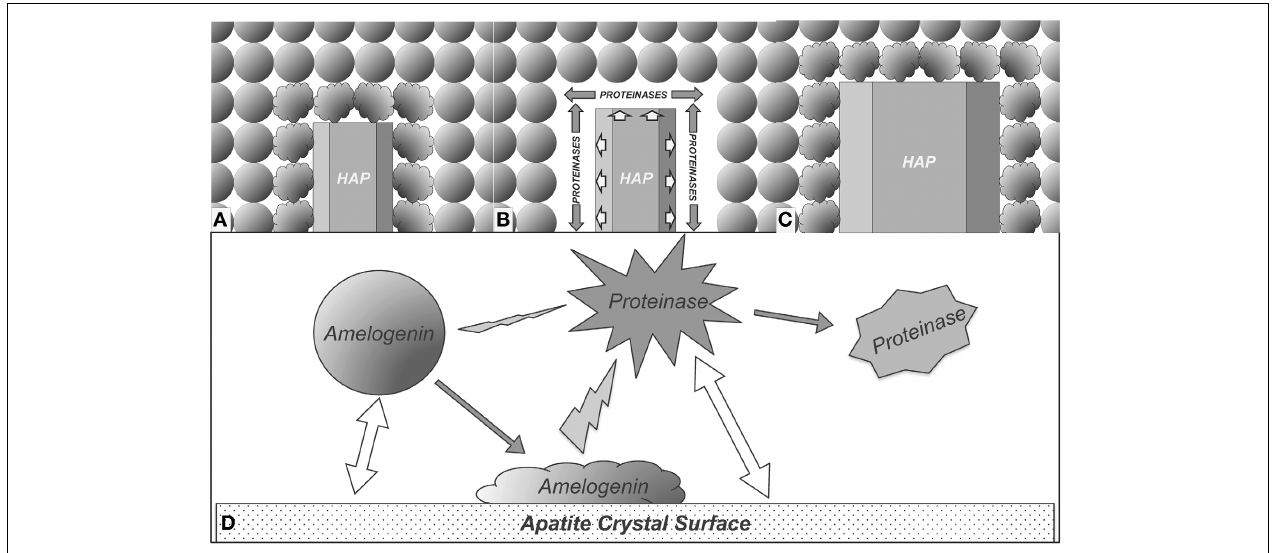
FIGURE 6 | Proposed model for enamel crystal growth guided by crystal-amelogenin-proteinase interactions. (A) HAP crystal interacts with amelogenins and causes their structural changes; (B) The structural changes of adsorbed amelogenins result in preferential amelogenin degradation on crystal surface; (C) Removal of the amelogenin on the crystal surface releases